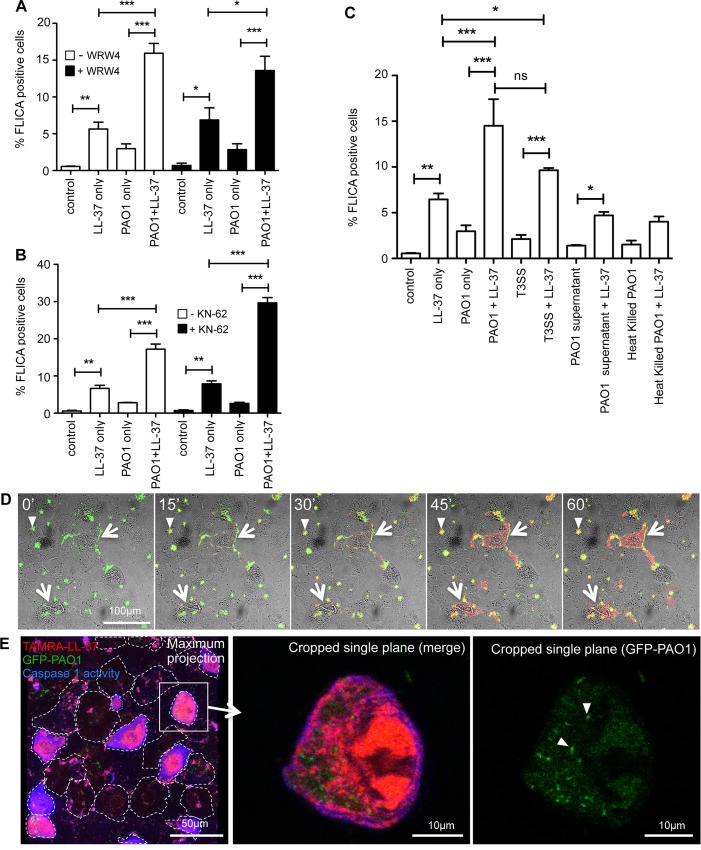
LL-37 preferentially accumulates in infected epithelial cells, activating caspase-1 via a P2X7R- and FPRL-1-independent mechanism.NHBE cells were exposed for 3 hours to media only (control), 20 μg/ml LL-37 only, PAO1/ heat killed PAO1/ P. aeruginosa strain T3SS at 10:1 MOI +/- 20 μg/ml LL-37, or PAO1 supernatant +/- 20 μg/ml LL-37. Some cells were pre-exposed for 1 hour to FPRL1 inhibitor WRW4 (10 μM) (A), or P2X7R inhibitor KN-62 (20 μM) (B). Caspase 1 activity was measured by FLICA assay (A–C). Data represent means +/- SEM from n = 3 independent experimental repeats, *** p < 0.001, ** p<0.01, * p<0.05, by 2-way ANOVA with Bonferroni Post-test. ns = no significant difference. D) Timelapse series of images (brightfield/fluorescence merge) taken by confocal microscopy showing GFP-PAO1 (green) adhering to NHBE cells (white arrows) with concentration of TAMRA-labelled LL-37 (red), on heavily infected cells. Scale bar = 100 μm. E) Representative maximum projection merged image of a field of NHBE cells stained with GFP-PAO1 (green), TAMRA-labelled LL-37 (red), and Brilliant Violet-YVAD (blue). Scale bar = 50 μm. Inset shows cropped single plane of one NHBE cell demonstrating GFP-PAO1 bacteria (white arrow heads) inside a TAMRA-LL-37 positive cell that is also positive for caspase 1 activation, indicated by Brilliant Violet-YVAD staining. Scale bar = 10 μm.